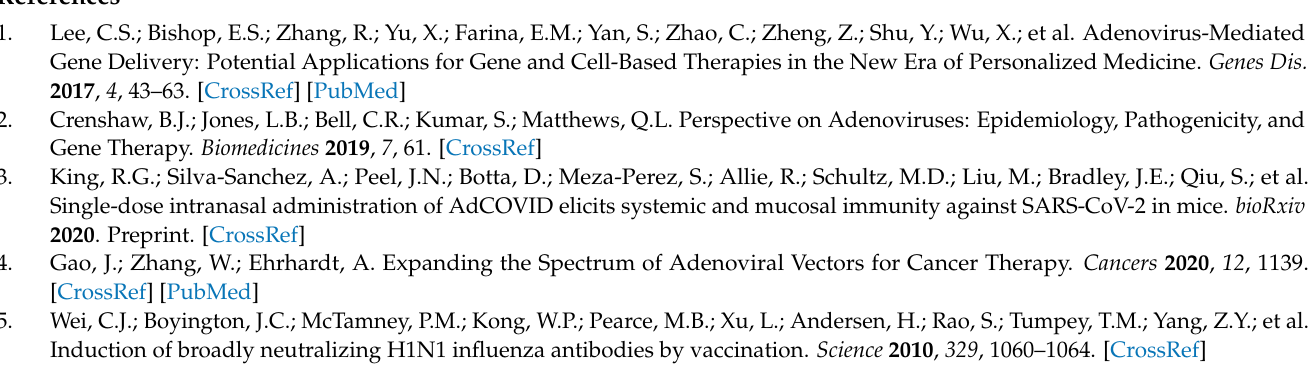
Figure S7: Morphology of immature (a) and mature (b) human monocyte-derived DCs transduced with HAdV-5-GFP with LentiBOOST®/Polybrene +LeB/PB) or PBS ( − LeB/PB), Figure S8: Lenti- Boost®/Polybrene enhances IL-8 secretion by immature, but not by mature human DCs, Figure S9: Differentiation of human monocyte subsets from PBMCs is not influenced by adenoviral transduction facilitated by LentiBoost®/Polybrene, Figure S10: Distribution of GFP+ human monocytes and monocyte-derived DCs, Figure S11: Viability of Monocytes assessed by a MTT assay, Figure S12: LentiBOOST®/Polybrene alters secretion of pro-inflammatory cytokines in untransduced mDCs, Figure S13: Mature DCs derived from transduced monocytes retain their capability to prime autolo- gous T cells in a tumor-antigen-specific